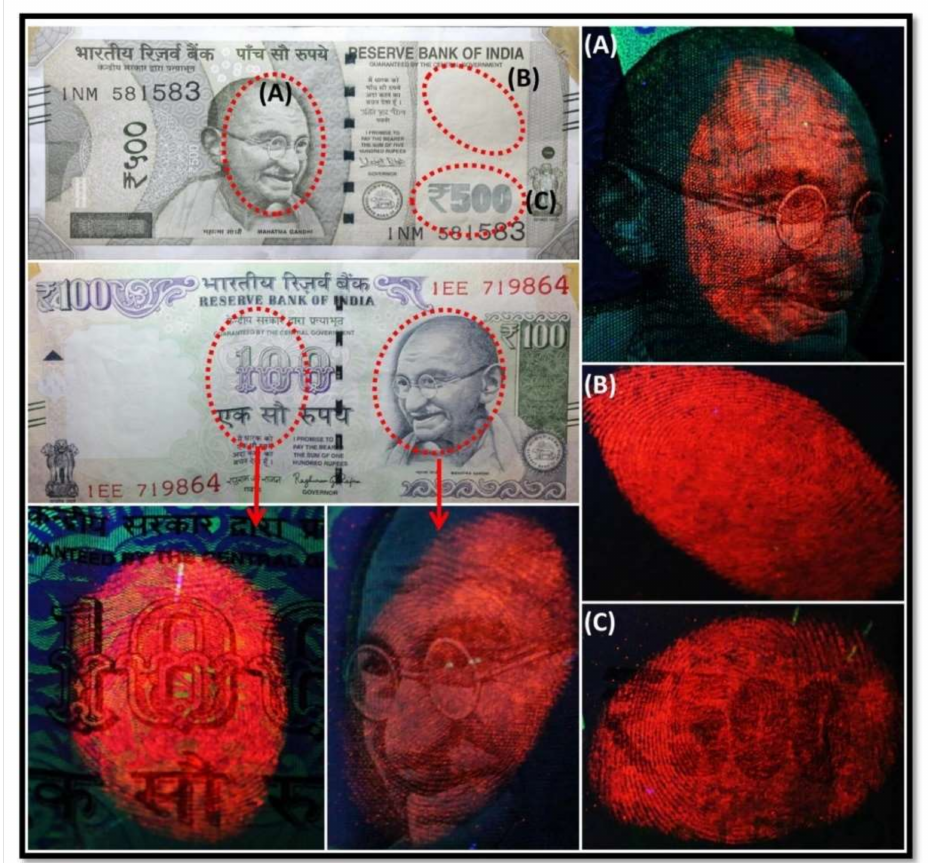
Figure 17. LFPs observed in different locations of a currency bill stained with Eu 3+ doped SnO 2 (7% Eu 3+ in mol), when illuminated by UV radiation with λ = 254 nm. ( A – C ) show different regions of the bill when illuminated by the UV radiation. The parts stained, illuminated with the UV light, and analysed are shown within red dashed circles on the bill pictures in the upper left and the central left panels of the figure. Reprinted with oermission from Reference [177]. Copyright 2019